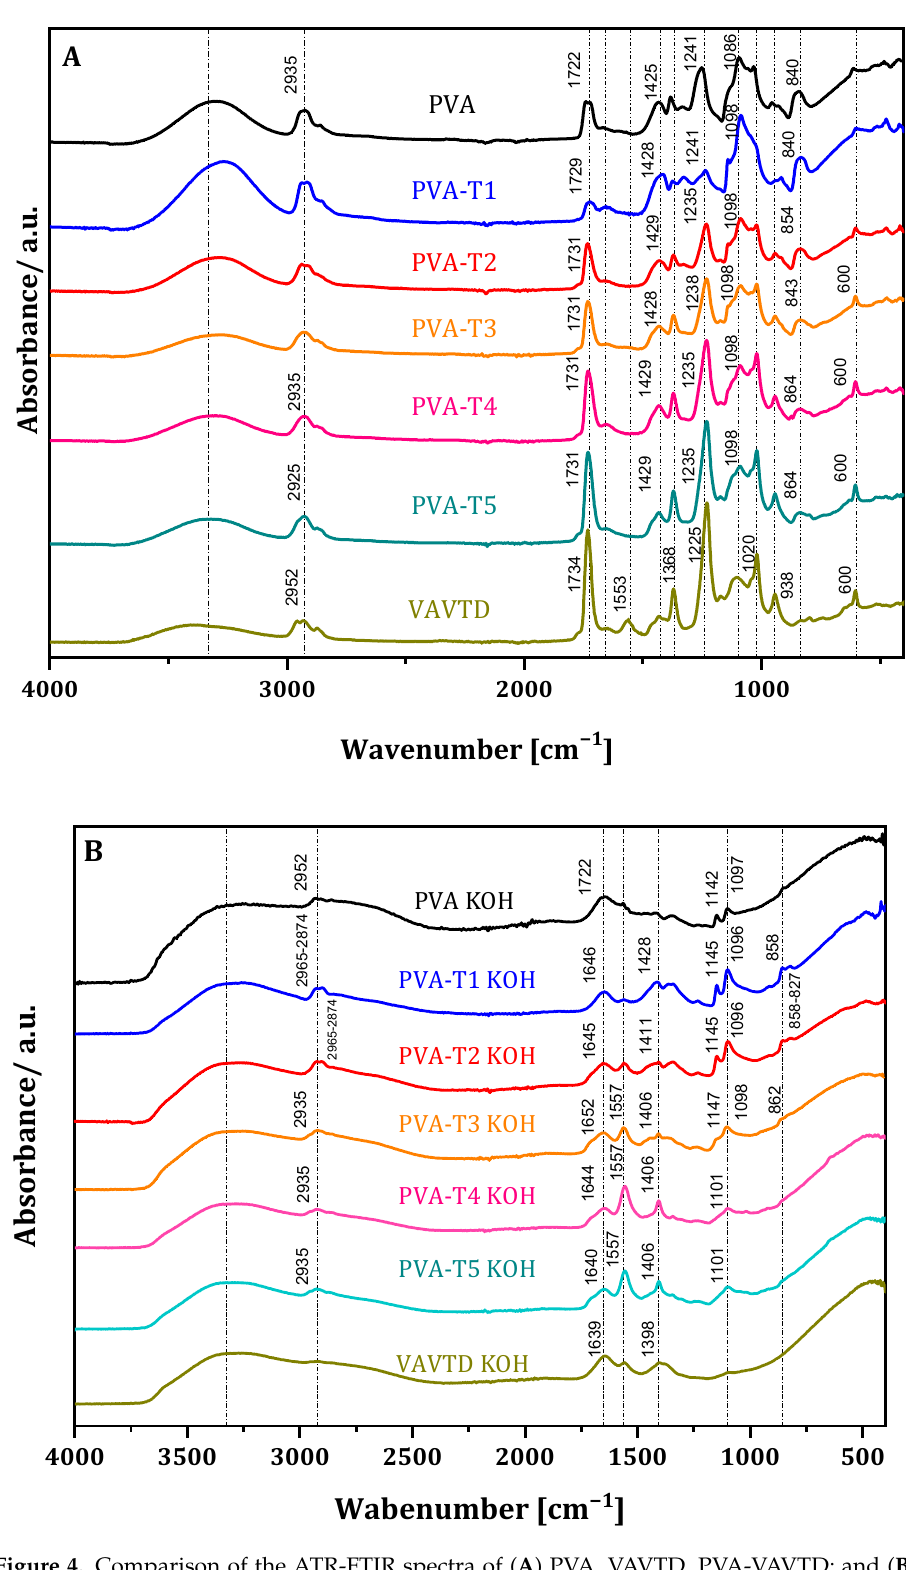
Figure 4. Comparison of the ATR-FTIR spectra of ( A ) PVA, VAVTD, PVA-VAVTD; and ( B ) PVA- VAVTD KOH membranes at different VAVTD proportions.